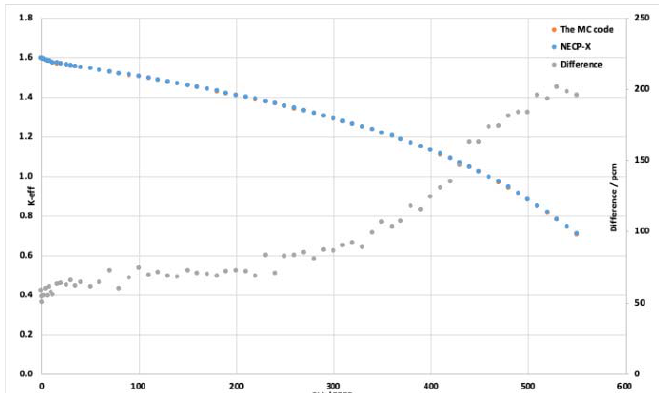
Figure 11. The k eff and difference for JRR-3M standard fuel assembly with burnup problem